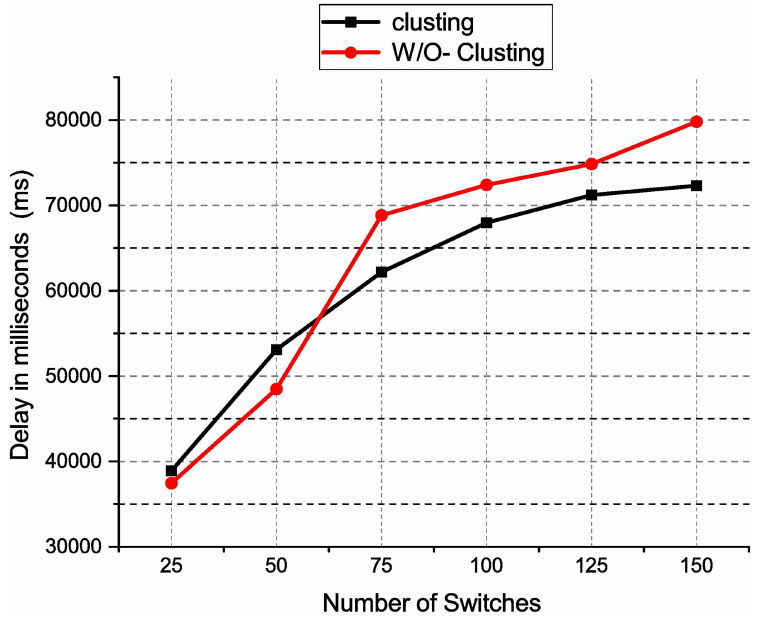
Fig 7. HP VAN controller latency